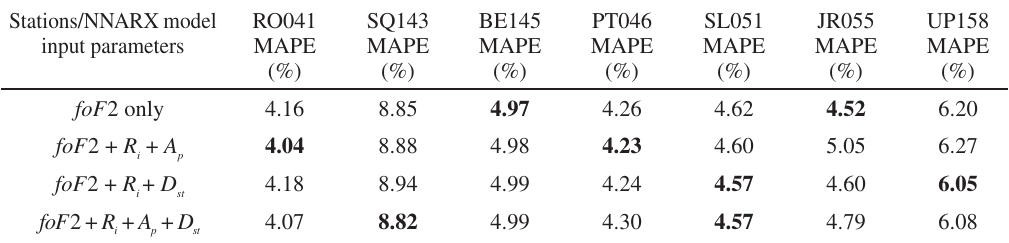
Table VI. MAPE (%) at different European ionospheric stations for September 1990. Stations/NNARX model input parameters